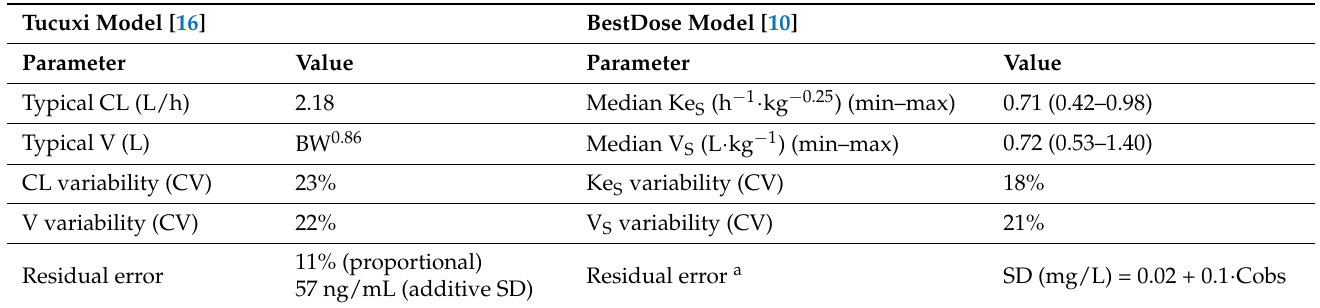
Table 1. Parameters of the busulfan PK models implemented in Tucuxi and